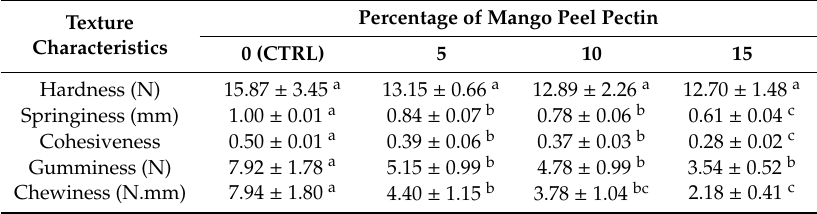
Figure 3. Texture profile of dried Chinese sausage with added mango peel pectin at di ff erent levels. Where; Hardness: F 1 ; Cohesiveness: A 2 / A 1 ; Springiness: d 2 / d 1 ; Gumminess: Hardness × Cohesiveness and Chewiness: Gumminess × Springiness. Table 3. Texture profile analysis of dried Chinese sausage with added mango peel pectin at di ff erent